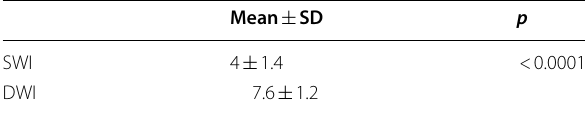
Table 3 SWI changes versus DWI changes